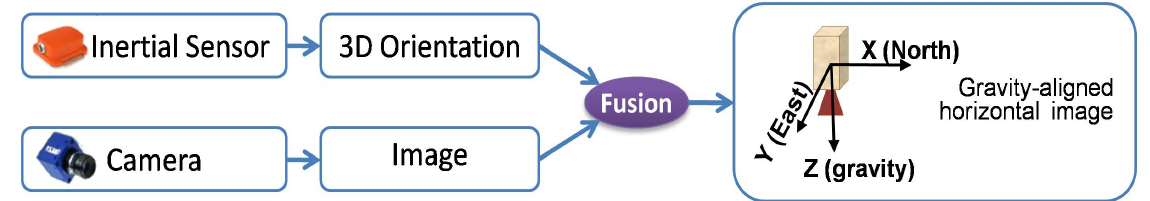
Figure 10. Virtual camera via fusion and downward looking co-ordinate